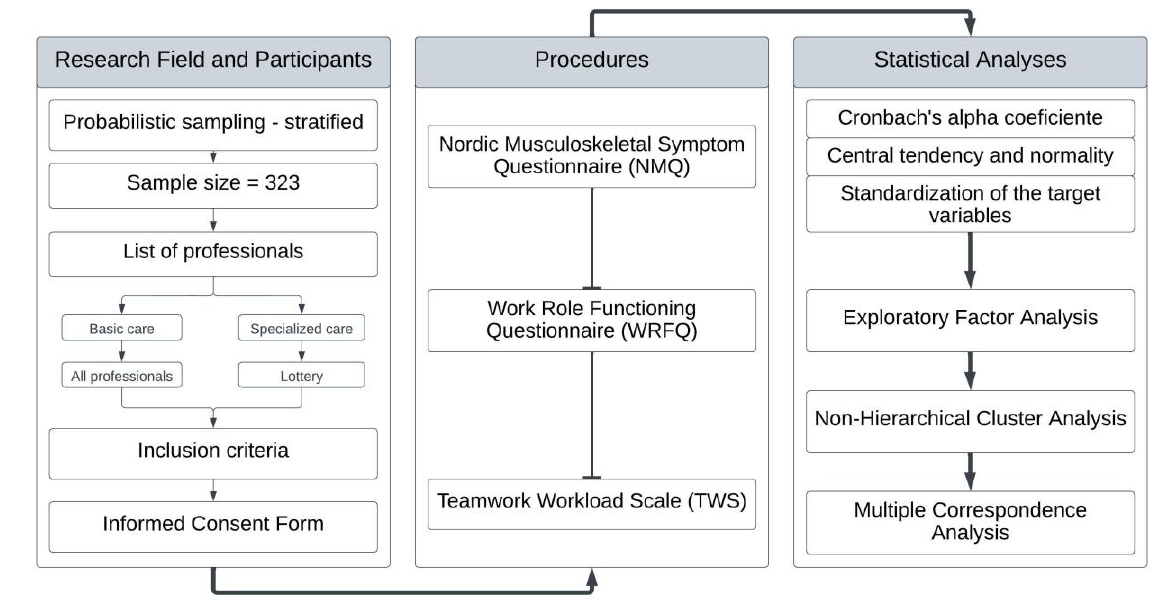
Figure 1. Workflow of the method.